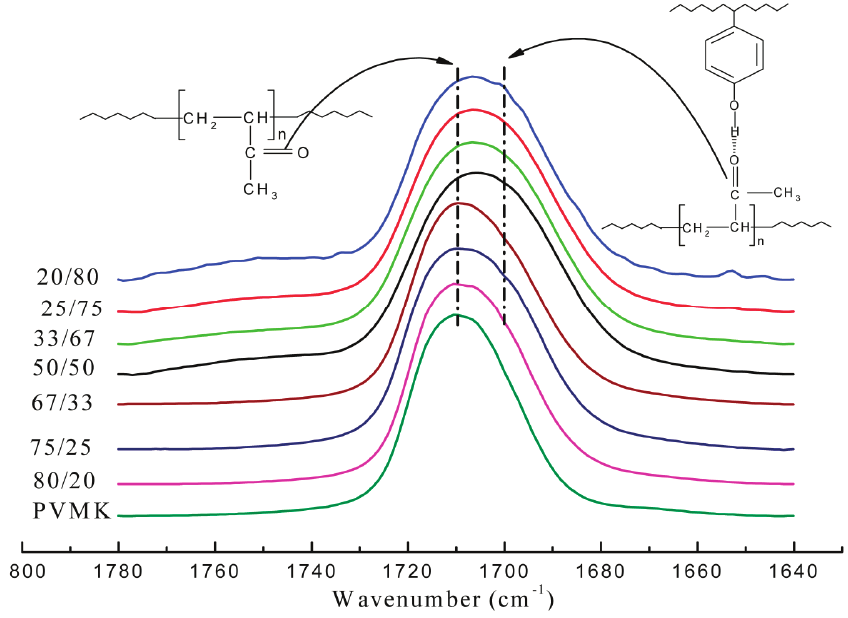
Figure 4. FTIR spectra of PVPh, PVMK and their blends in the 1650–1780 cm − 1